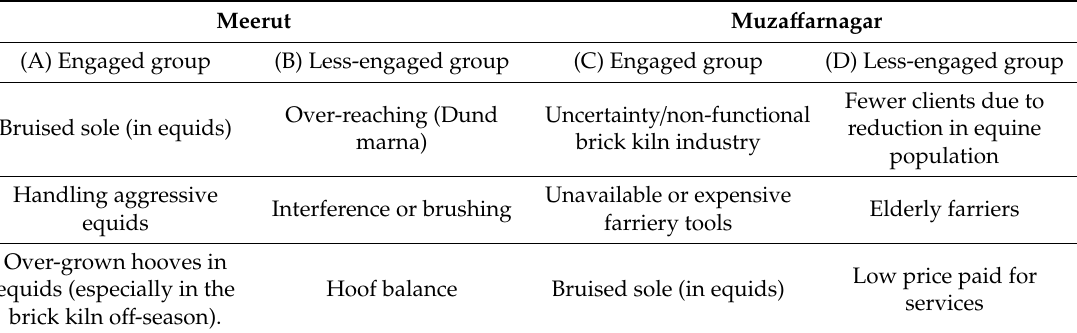
Table 2. Top three challenges faced by local farriers (results of pairwise